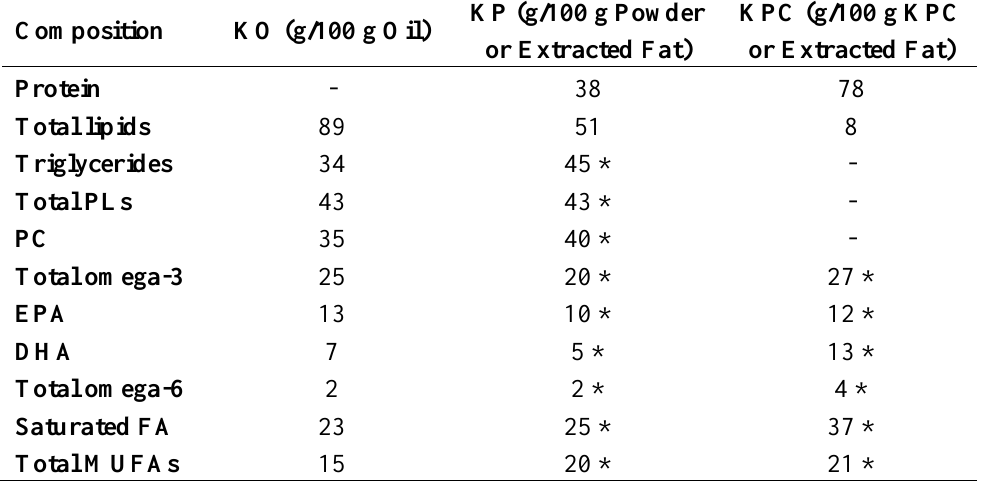
Table 1. Krill oil (KO), krill powder (KP) and krill protein concentrate (KPC) compositions—Typical